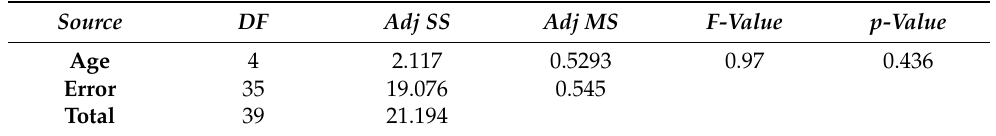
Table 12. Analysis of variance between lean and age .